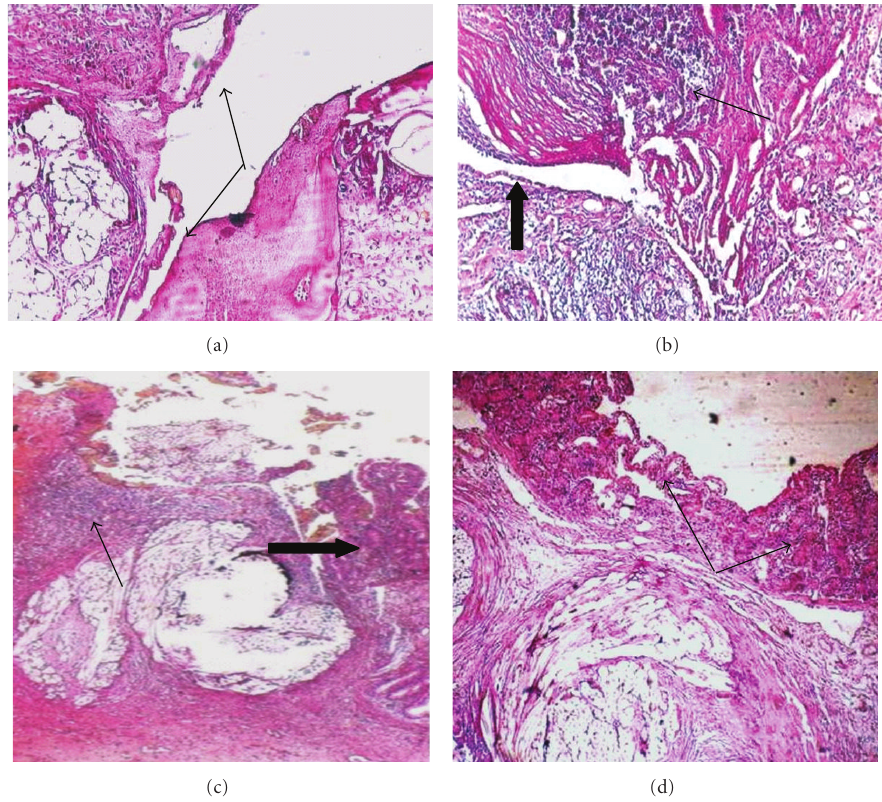
Figure 4: Histopathology photographs of experimental intestinal anastomosis in goat, HMIS group. (a) On 4th POD: degeneration, necrosis, fibroblasts, infiltration of neutrophils, and necrosis of intestinal villi, (arrows), H&E × 10. (b and c) On 14th POD: connective tissue, wound edges infiltrated with macrophages and lymphocytes (thin arrow), and few intestinal epithelial cell infiltrated from intact intestinal glands (thick arrow), H&E × 20. (d) On 21st POD: organization of connective tissue, fibroblasts in an anastomosis area and short villi lined the intestinal mucosal surface (arrows), H&E stain, ×